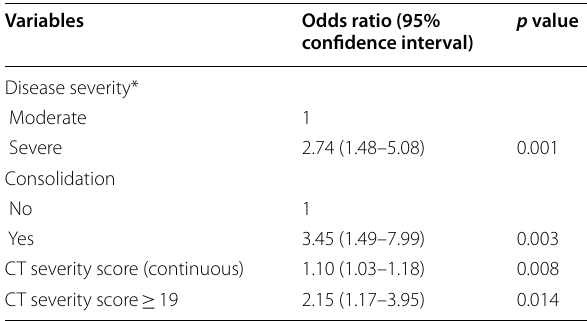
Table 2 Factors associated with post-COVID-19 lung fibrosis in logistic regression